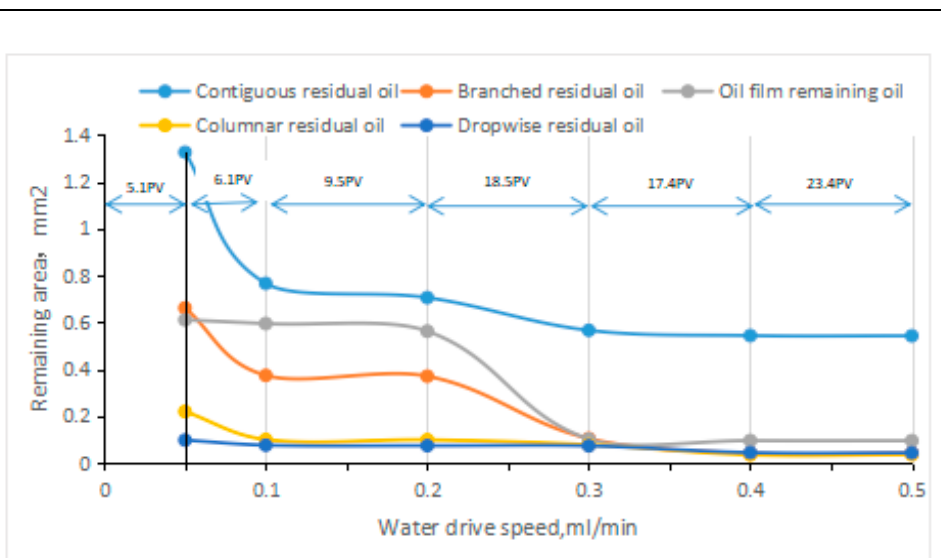
Figure 11. Effect of different displacement rates on displacement efficiency of different types of remaining oil.